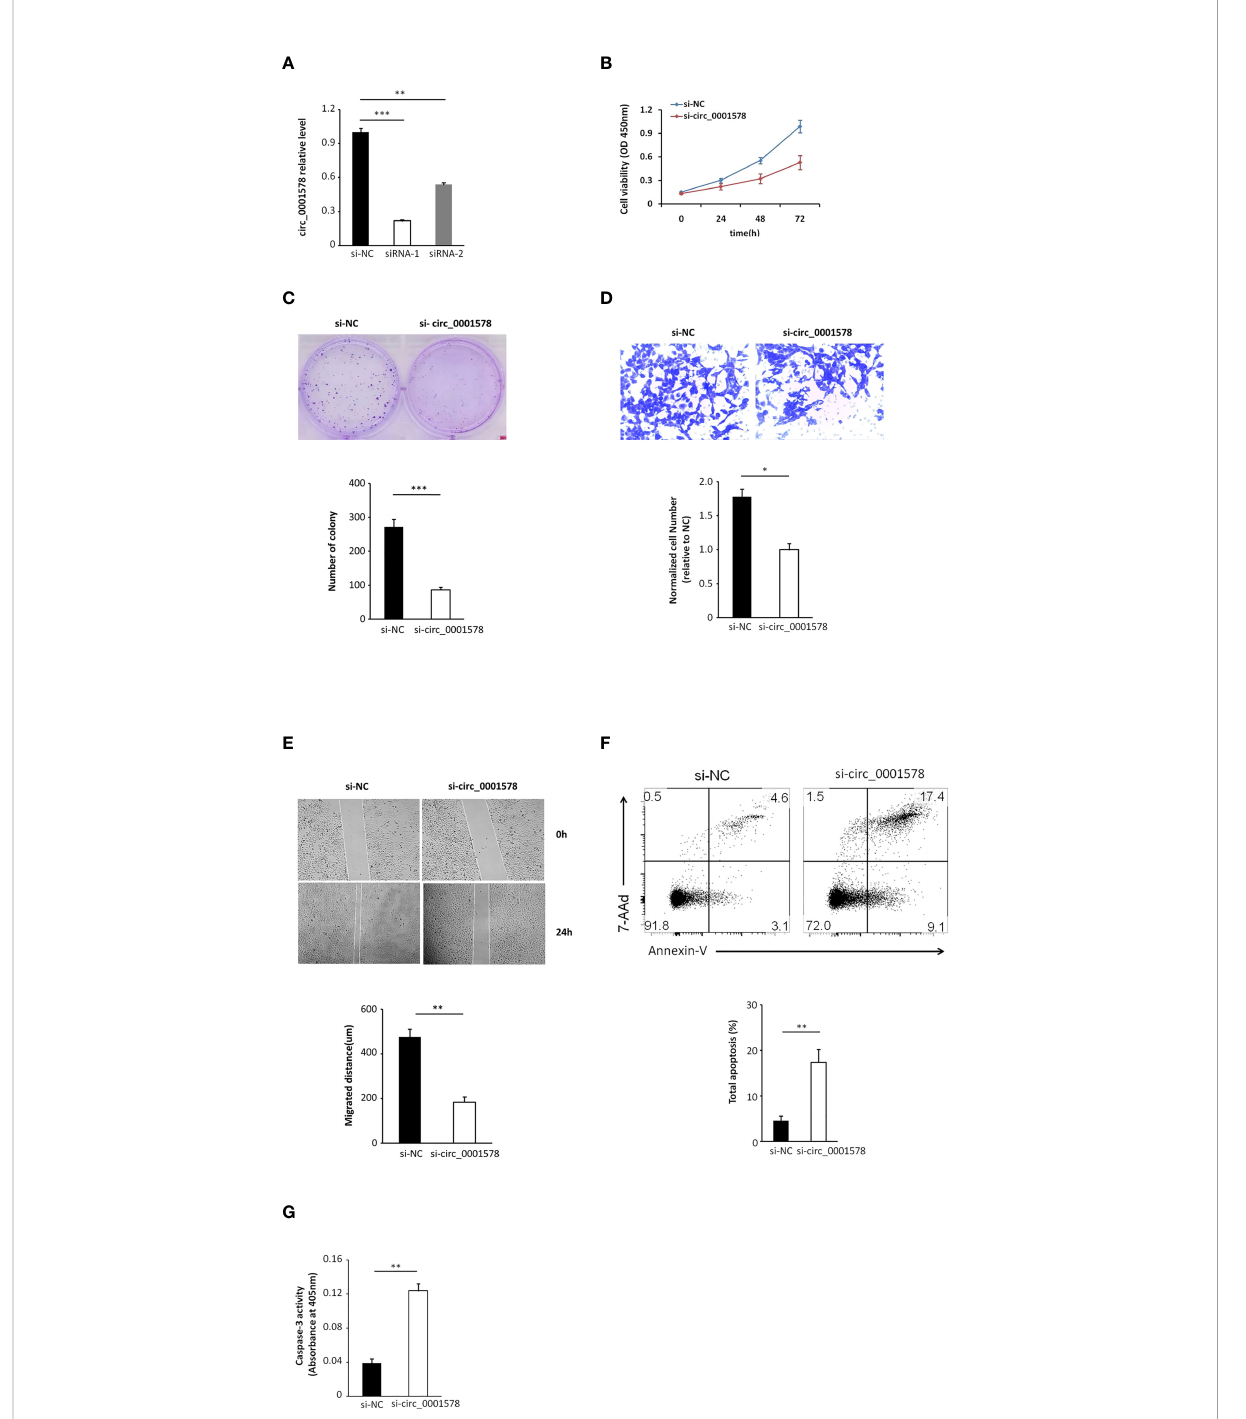
FIGURE 3 Downregulation of circ_0001578 inhibits proliferation and migration and induces apoptosis in trophoblast cells. (A) The interference ef fi ciency of si-circRNAs was determined by qRT-PCR (siRNA-1, P < 0.001; siRNA-2, P < 0.01). (B) Viability of HTR-8/SVneo cells after si-circRNA or si-NC treatment at 48 and 72 h after transfection (P < 0.05 at 48 h, P < 0.01 at 72 h). (C) Clone formation assay of HTR-8/SVneo cells transfected with si-circRNA or si-NC (P < 0.0001). (D) Migration ability of HTR-8/SVneo cells transfected with si-circRNA or si-NC was determined by a transwell assay (P < 0.05). (E) Migration ability of HTR-8/SVneo cells transfected with si-NC or si-circRNA was determined by a wound healing assay (P < 0.01). (F) Apoptosis of HTR-8/SVneo cells transfected with si-NC or si-circRNA was determined by Annexin-V staining (P < 0.01). (G) Apoptosis of HTR-8/SVneo cells transfected with si-NC or si-circRNA was determined by caspase-3 assays (P < 0.01) *P<0.05; **P<0.01;